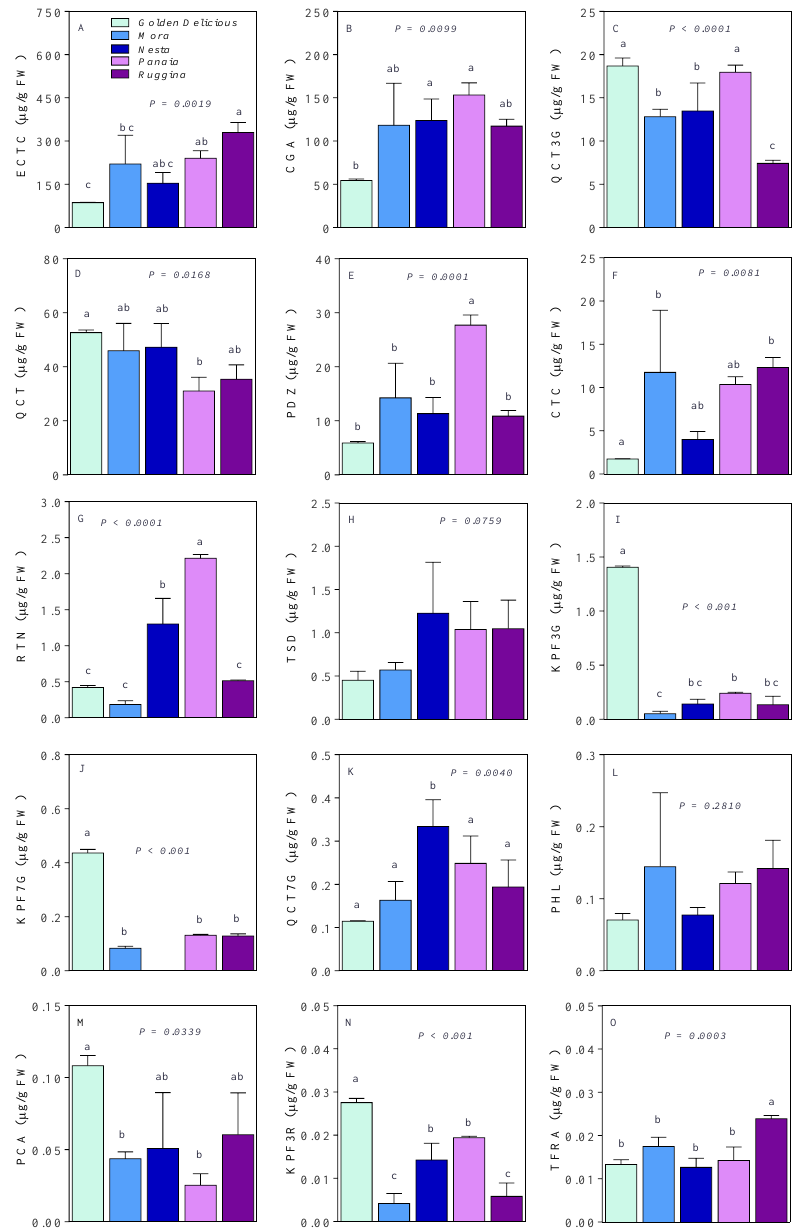
Figure 1. Mean values and standard deviations for concentrations (μg g-1 FW) of ( A ) (−)-epicatechin (ECTC), ( B ) chlorogenic acid (CGA), ( C ) quercetin 3- O -glucoside (QCT3G), ( D ) quercetin (QCT), ( E ) phloridzin (PDZ), ( F ) (+)-catechin (CTC), ( G ) rutin (RTN), ( H ) tiliroside (TSD), ( I ) kaempferol 3- O -glucoside (KPF3G), ( J ) kaempferol 7- O -glucoside (KPF7G), ( K ) quercetagetin 7- O -glucoside (QGT7G), ( L ) phloretin (PHL), ( M ) p -coumaric acid (PCA), ( N ) kaempferol 3- O -rutinoside (KPF3R), ( O ) trans -ferulic acid (TFRA) determined by the analysis of QTRAP for fresh apples. Data ( n = 3) were analyzed by one-way ANOVA. Tukey’s post-hoc test at 0.05 probability level was applied and different letters indicated significant difference among means.